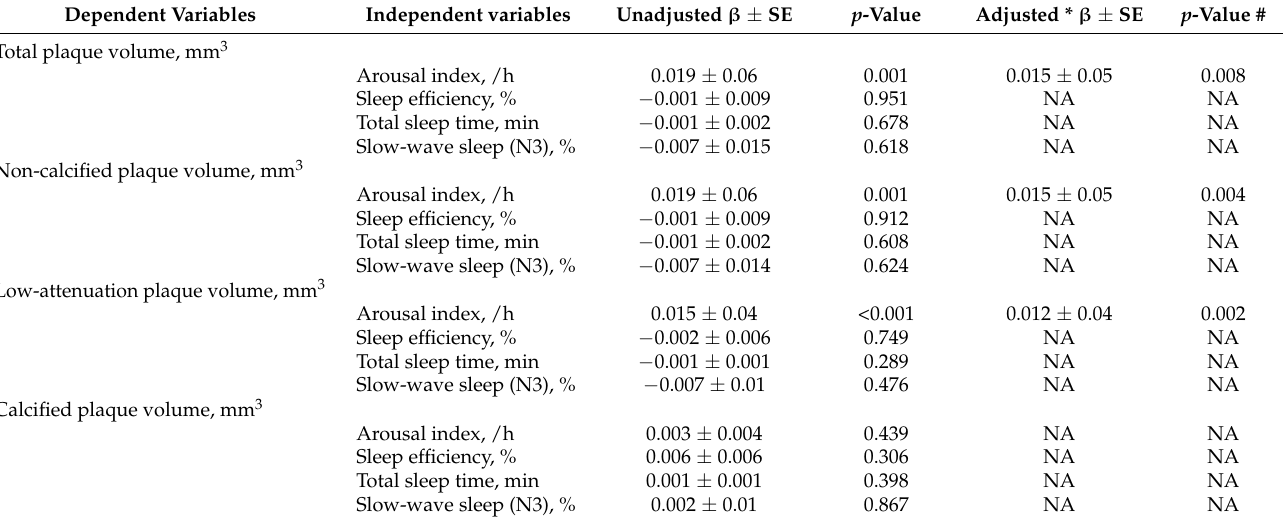
Figure 2. Volume and composition of coronary plaque between patients with a low ArI and patients with a high ArI. ( a ) Total plaque volume; ( b ) noncalcified plaque volume; ( c ) low-attenuation plaque volume; ( d ) calcified plaque volume. ** indicate p -Value <0.01; *** indicate p -Value <0.001. ArI = arousal index. Table 3. Linear models assessing the association between sleep measures and coronary plaque